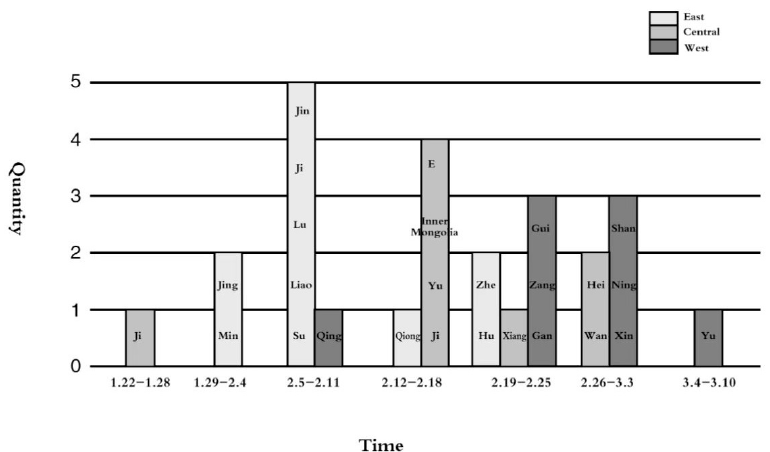
Figure 2. Spatiotemporal map of policy release. Ji represents Jilin Province; Jing represents Beijing; Min represents Fujian Province; Jin represents Tianjin; Ji represents Hebei Province; Lu represents Shandong Province; Liao represents Liaoning Province; Su represents Jiangsu Province; Qing rep- resents Qinghai Province; Qiong represents Hainan Province; E represents Hubei Province; Inner Mongolia represents Inner Mongolia Autonomous Region; Yu represents Henan Province; Jin rep- resents Shanxi Province; Zhe represents Zhejiang Province; Hu represents Shanghai; Xiang repre- sents Hunan Province; Gui represent Guizhou Province; Zang represents the Tibet Autonomous Region; Gan represents Gansu Province; Hei represents Heilongjiang Province; Wan represents An- hui Province; Shan represents Shaanxi Province; Ning represents Ningxia Autonomous Region; Xin represents the Xinjiang Uyghur Autonomous Region; Yu represents Chongqing.